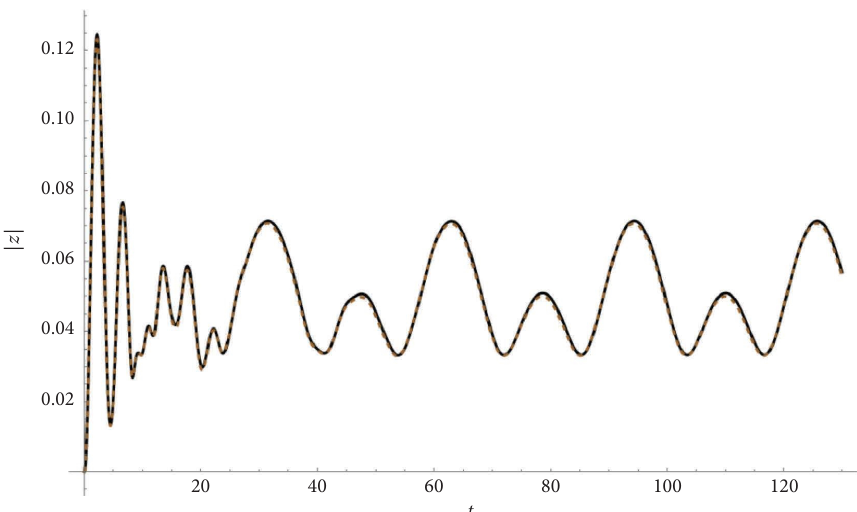
Figure 6: Absolute value | z | compared with the Runge–Kutta numerical